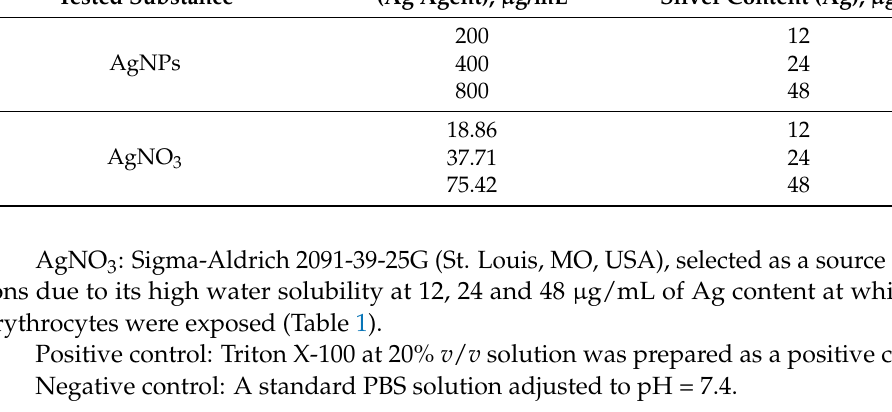
Table 1. Concentrations in assay for Ag contained in Argovit™ AgNPs and AgNO 3 . Tested